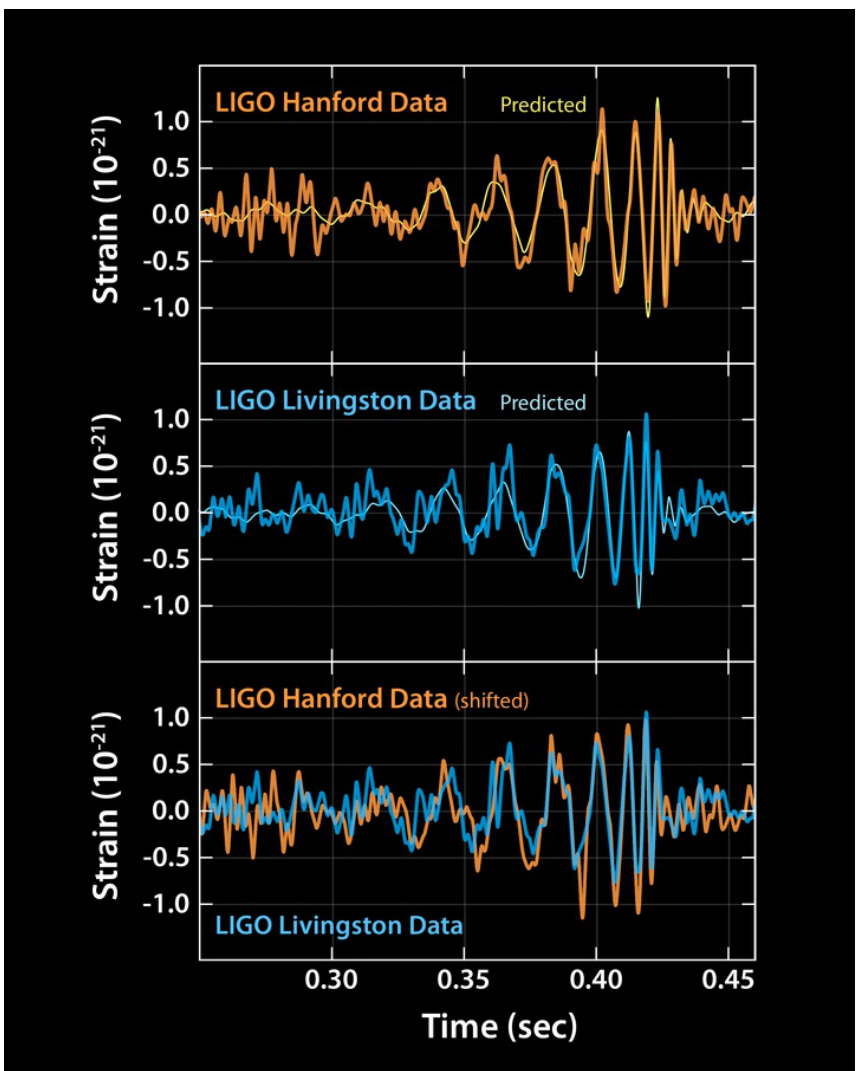
Figure 3. Plots of the first signal of GWs observed by the two LIGO detectors. The top two panels show data received at LLO and LHO and the waveform calculated, taking GR into account. The X-axis represents the time, and Y-axis represents the strain. Strain implies the slight variations in the distances. The bottom plot compares data from both detectors. There is a variation in the orientation of the instruments at the two sites. Therefore, LHO data have been inverted for comparison. There is also a shift in data to include the GW signals’ travel time between Livingston and Hanford (Courtesy Caltech/MIT/LIGO Laboratory)